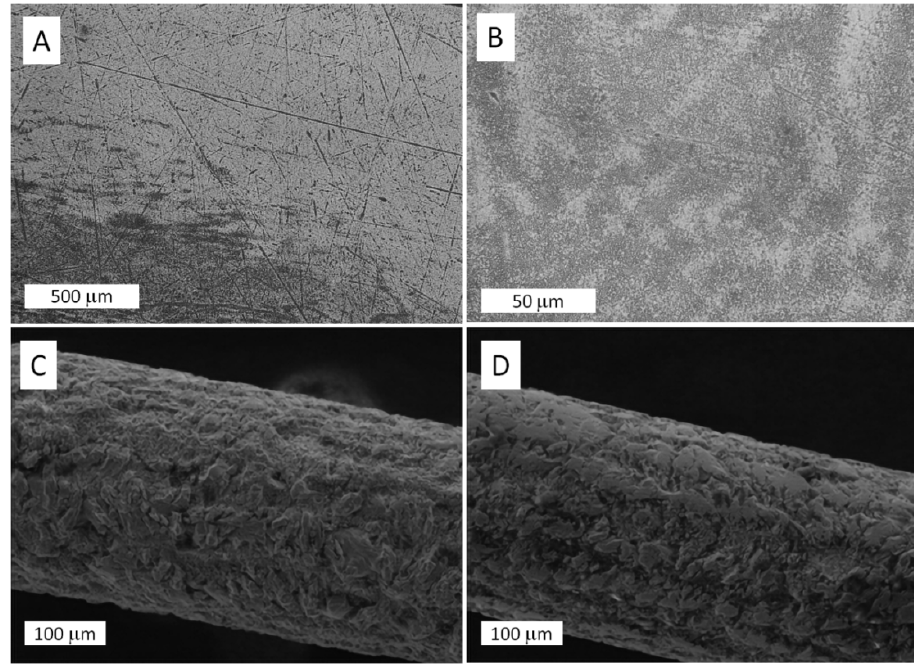
Figure 2. Microphotographs of the surface of the Ti–25Nb–13Ta–5Zr alloy. ( A ) Optical microphotograph of the surface of the alloy after smelting. ( B ) Optical microphotograph of the surface of the alloy after polishing. ( C ) SEM photograph of the surface of a Ti–25Nb–13Ta–5Zr alloy wire after formation. ( D ) SEM photograph of the surface of a Ti–25Nb–13Ta–5Zr alloy wire after polishing.